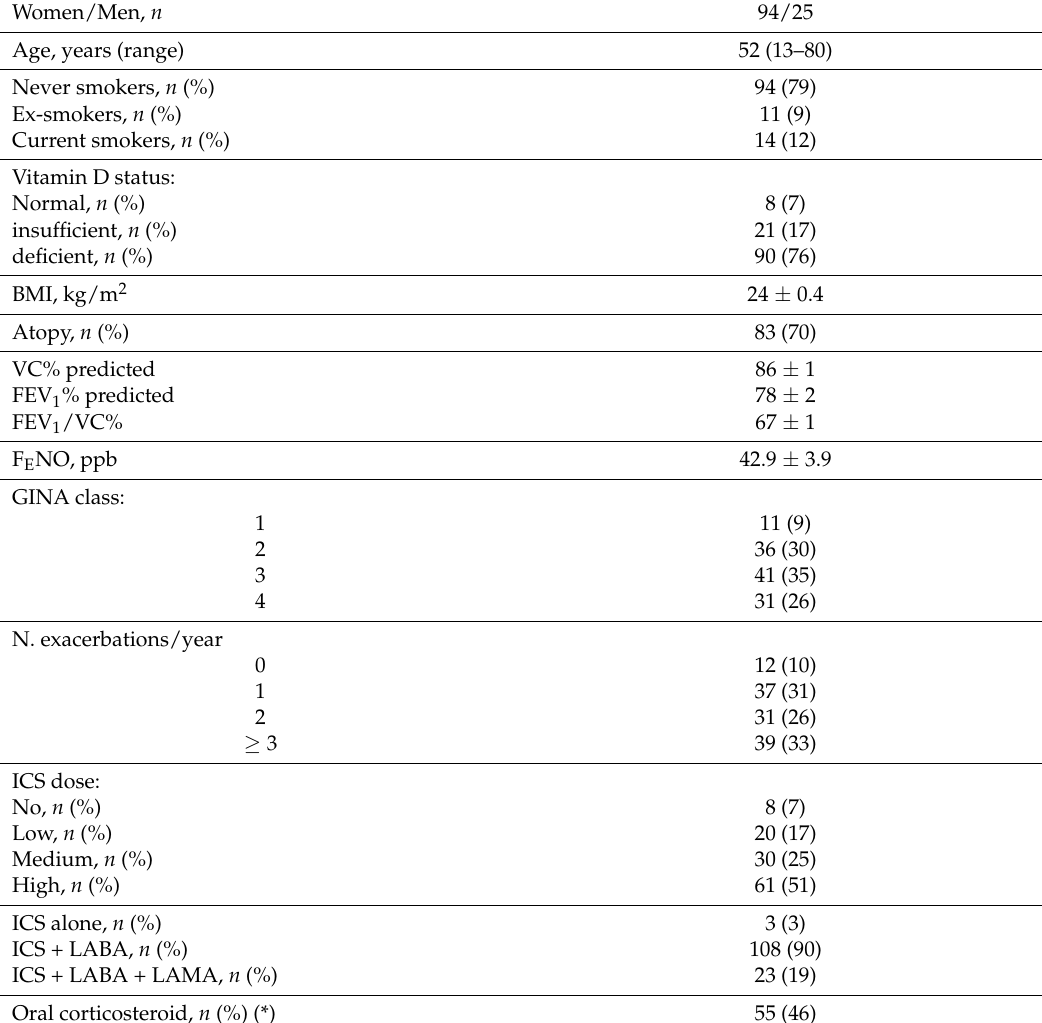
Table 1. General characteristics of the 119